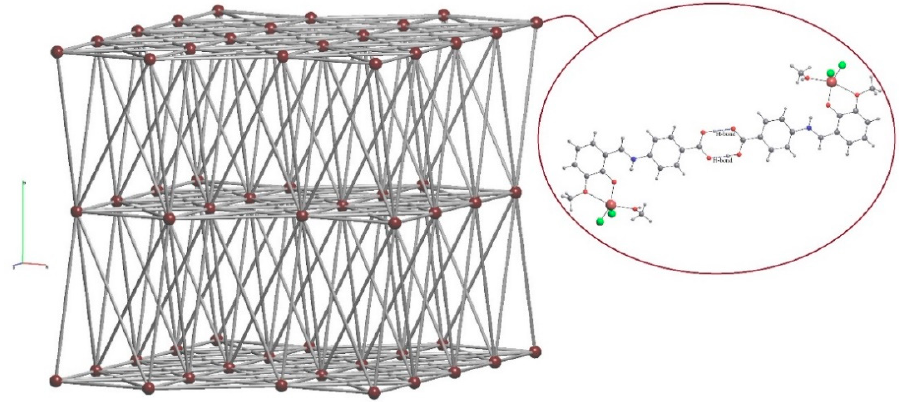
Figure 4. Underlying net for complex 1 for which the nodes represent its dimers.